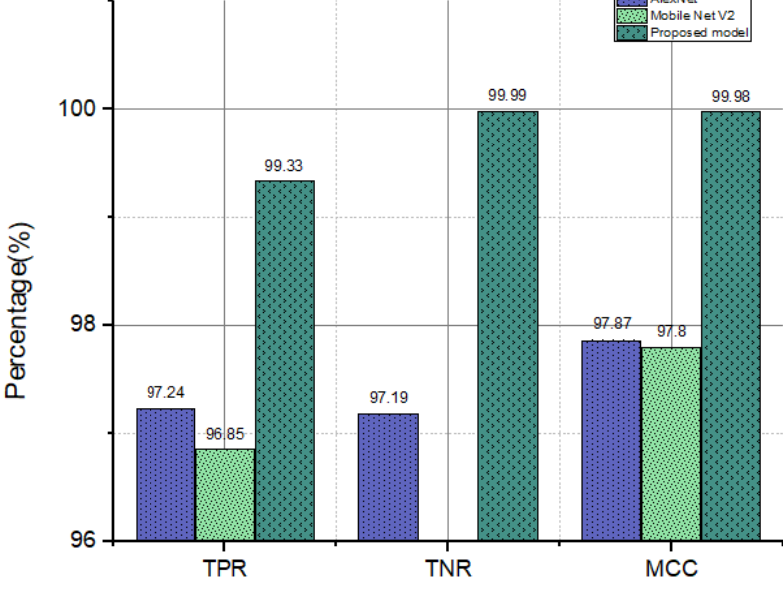
Figure 12. TNR, TPR, and MCC analysis.